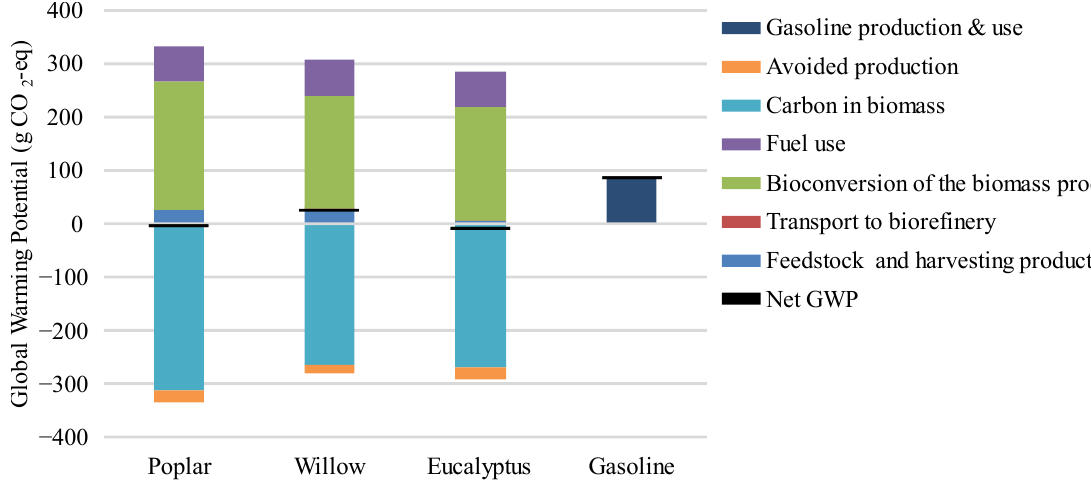
Figure 4. Comparison of the GWP of poplar in this study with the GWP of willow, eucalyptus, and gasoline extracted from [29]. The black line represents the net GWP for each fuel.